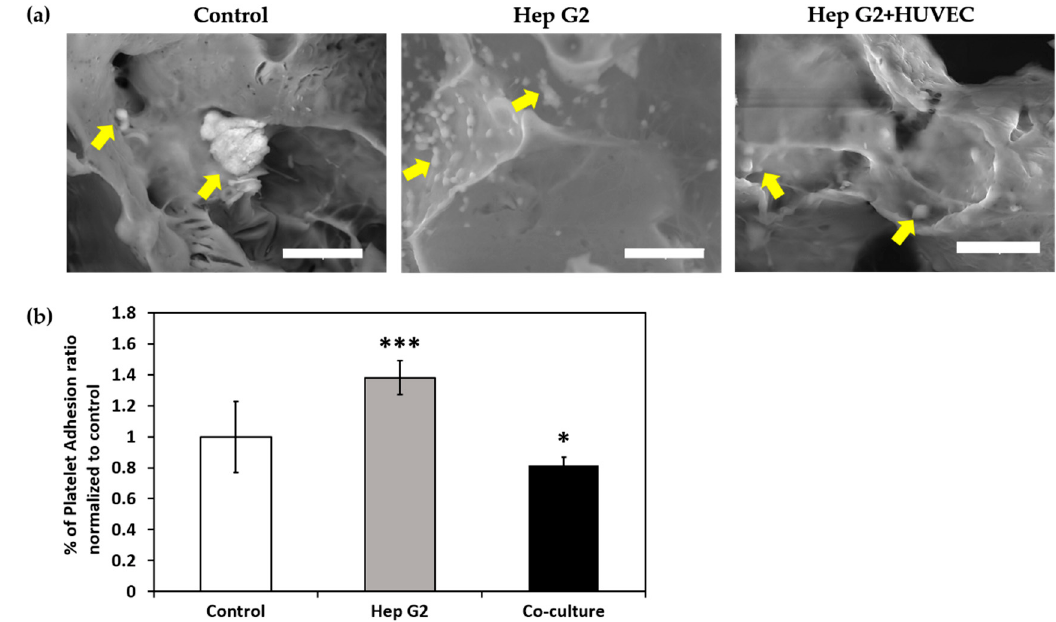
Figure 6. Hemocompatibility assessment: ( a ) SEM images of scaffold deposited with platelets on the control (no cell), Hep G2-covered scaffold, and co-culture (Hep G2 +HUVEC) scaffold. Platelet deposition and aggregation are shown by yellow arrows (scale bar is 20 µm, magnification 1000×); ( b ) The % of platelet adhesion ratio (% of PAR) of the Hep G2-covered scaffold and co-cultured scaffold normalized to the control. Each column represents mean ± SD with n = 3 independent experiments, * P < 0.05, *** P < 0.005 versus control.